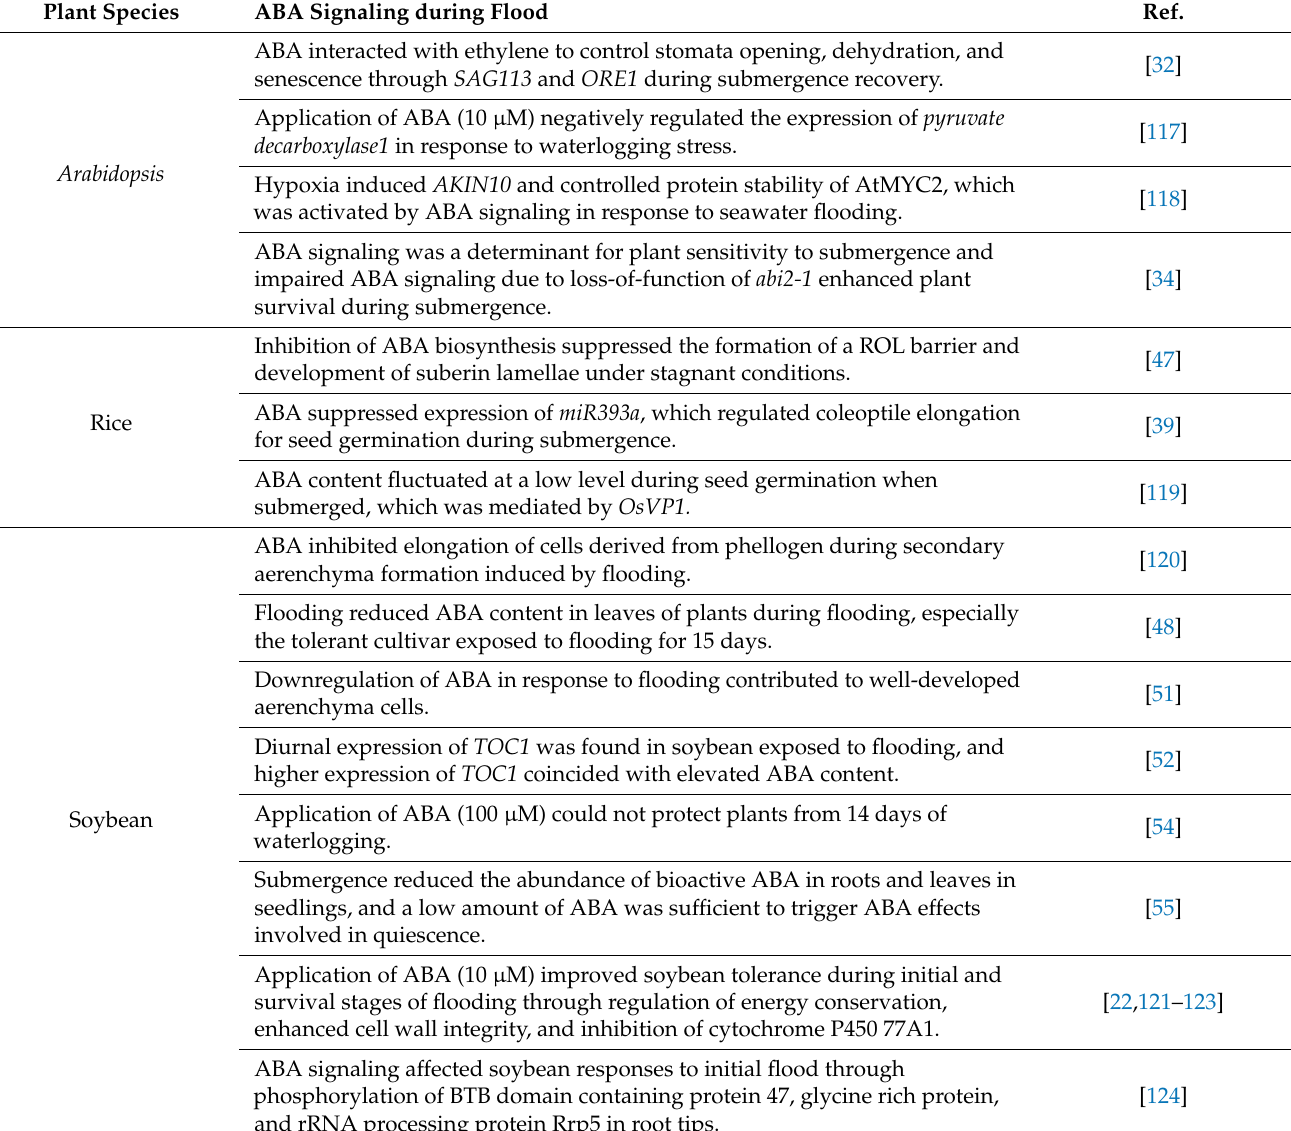
Table 3. ABA signaling in plants to flooding